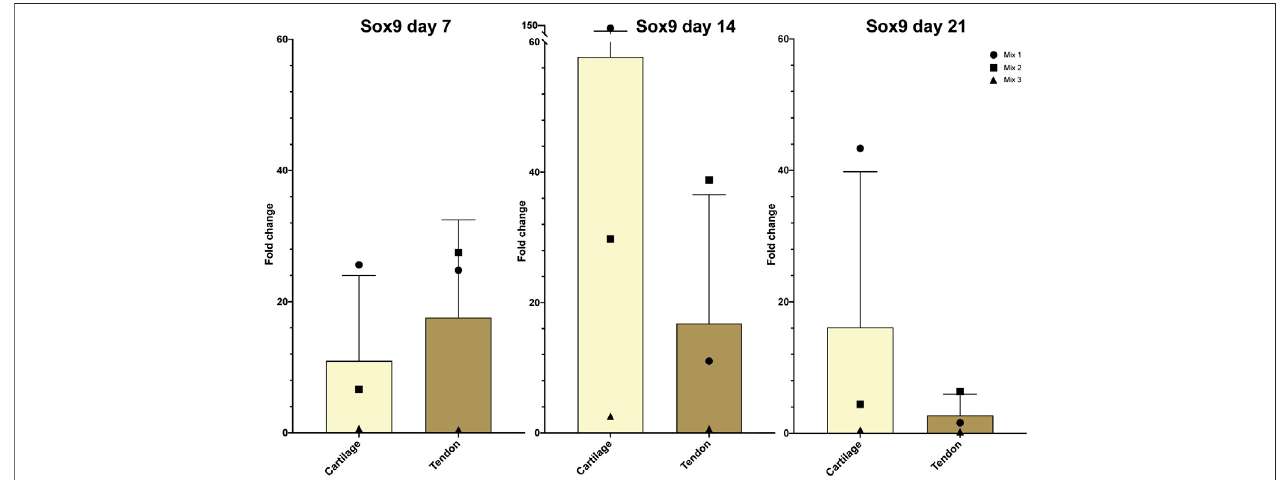
FIGURE 3 | Relative expression of SOX9 after days 7, day 14, and day 21 in hMSC-seeded constructs cultured within bioreactors. Gene expression levels are expressedasfold-changenormalizedtothatinday0samples.Datawereanalyzedusingtwo-wayANOVAfollowedbyTukey ’ s posthoc test.Resultsarereportedasthe mean of three measurements ± SD, p < 0.05 was considered statistically signi fi